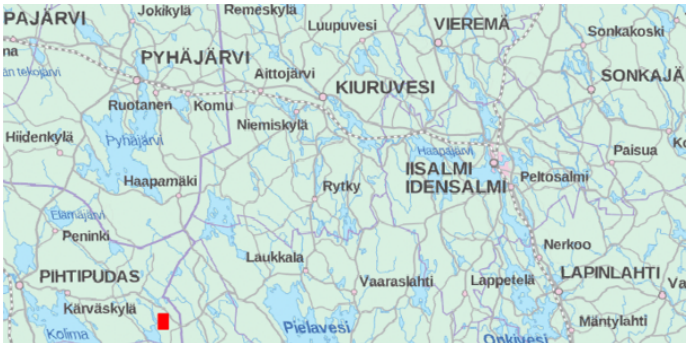
Figure 3. Google map picture with red borders showing the location